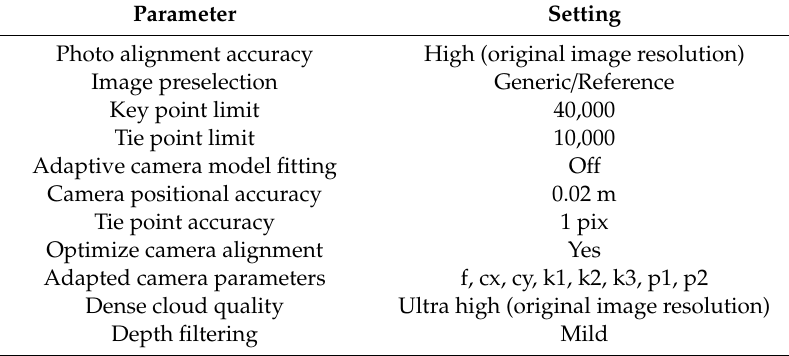
Table 3. UAS data-processing parameters (Agisoft Metashape 1.5.1). Camera parameters